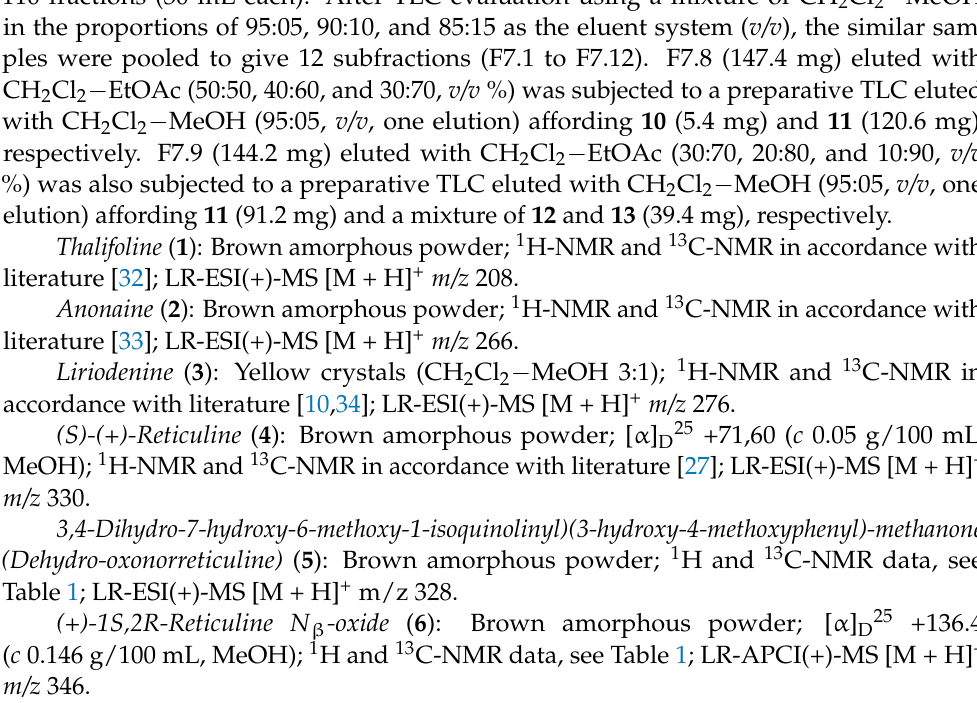
Table 1; LR-ESI(+)-MS [M + H] + m/z